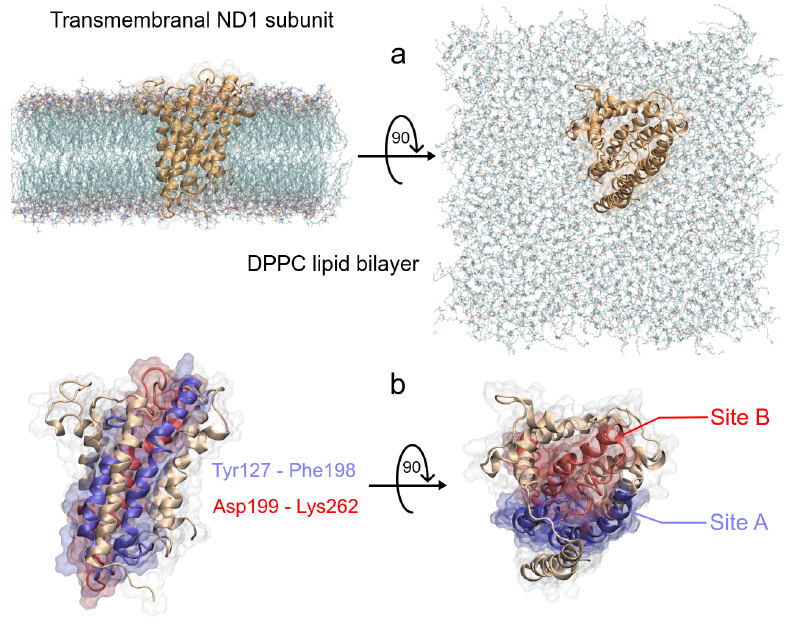
Figure 3. Schematic representation of the ND1—DPPC membrane complex, ( a ) initial distribution of the simulated model used in the MD simulation, the lengths of the simulation box are lx = 11.66 nm, ly = 11.71 nm and lz = 13.02 nm. ( b ) Front and top views of the active site of ND1 protein, in purple color, the active site A, and in red color, the active site B.